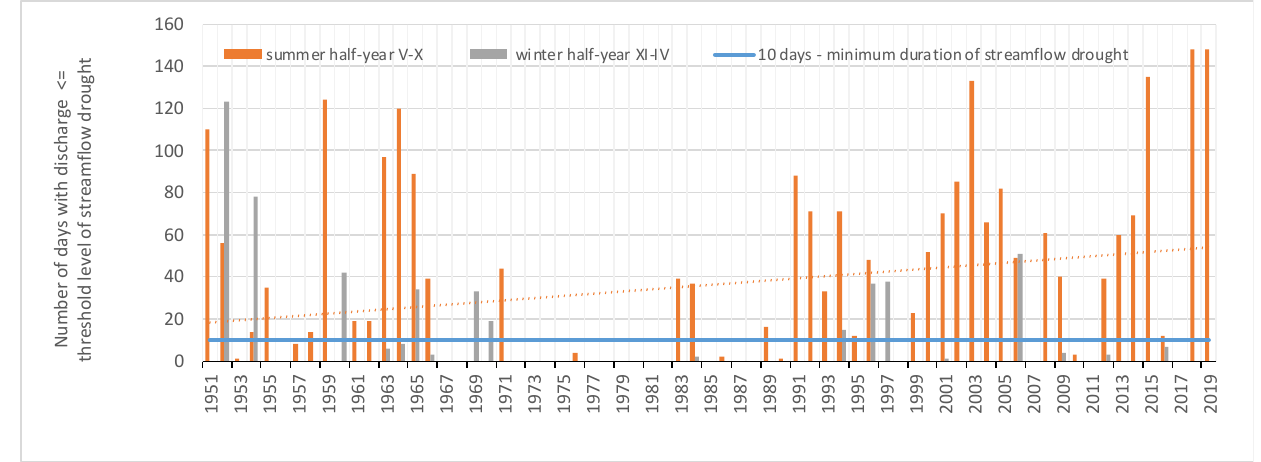
Figure 18. The number of days of low flows (Q n ≤ 0.79 m 3 s − 1 for the 1951–2002 period) in the 1951–2020 period at the Narewka gauging station. The blue line marks the minimal number of days (10 days) when the streamflow droughts are defined. Annotation: The winter half-year of 1952 includes days (1 XI-23I) defined as being like the summer drought of 1951.